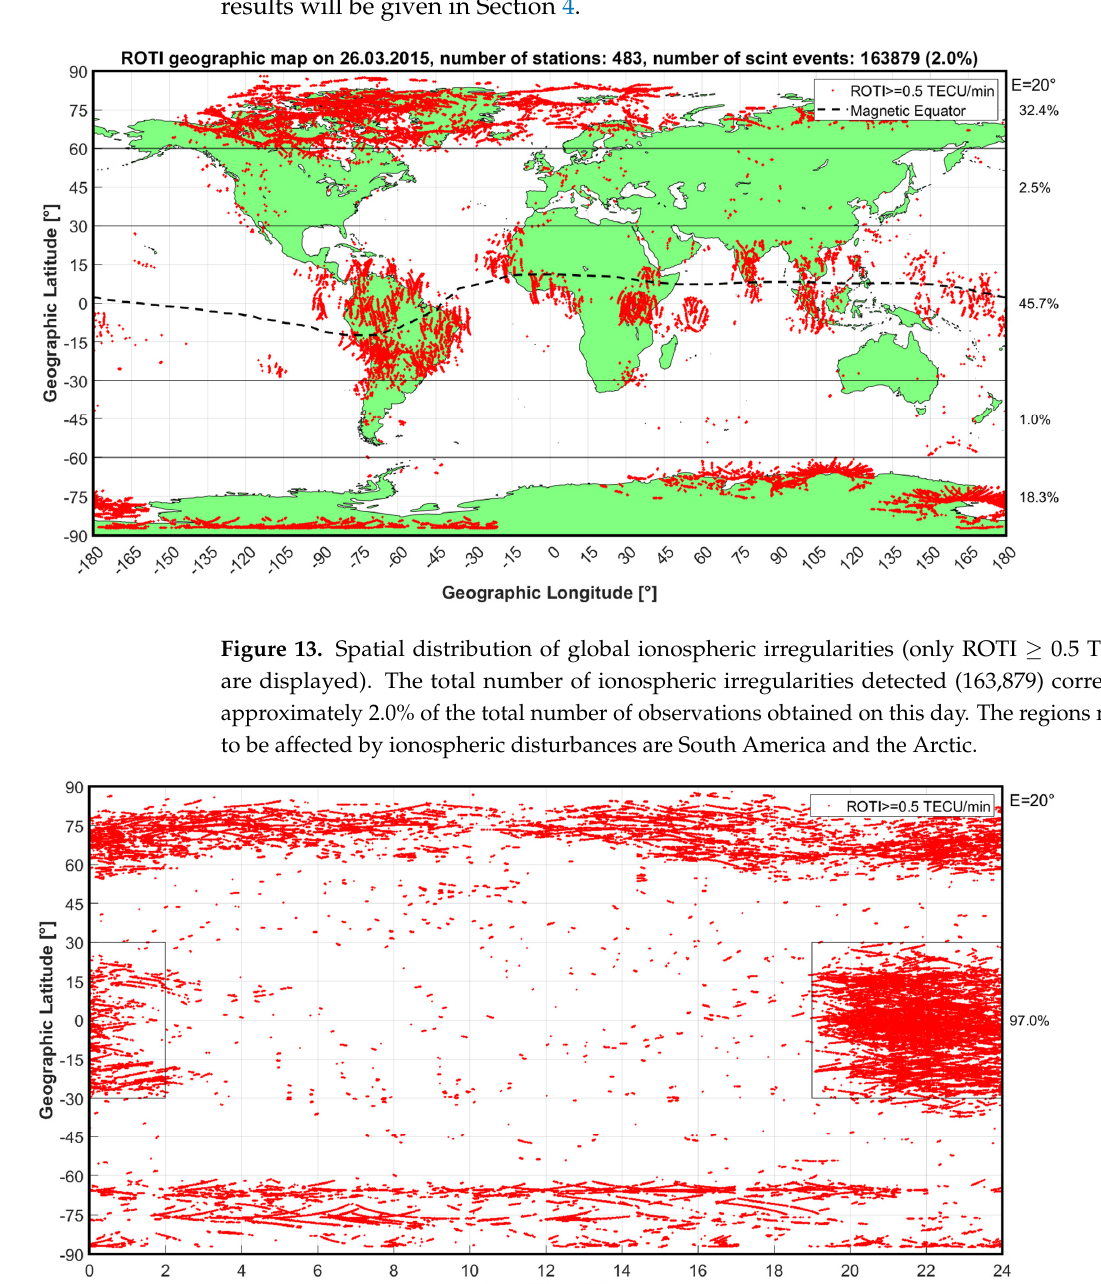
Figure 14. Temporal distribution of global ionospheric irregularities, showing clear differentiation by latitudinal region. In the low-latitude regions, about 97.0% of ionospheric irregularities detected appear during the evening hours, i.e., from 19 LT to 2 LT the next day. The remaining 3.0% only occur scattered during different times of the